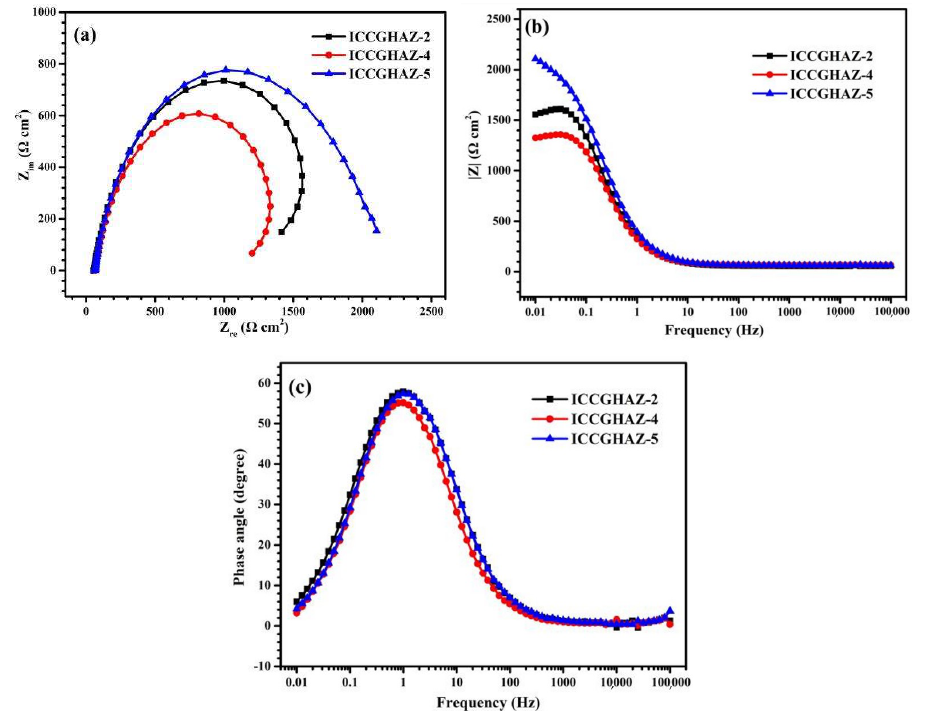
Figure 17. EIS results of the ICCGHAZs with different cooling rates in 3.5 wt% NaCl solution: ( a ) Nyquist impedance diagrams, Bode diagrams of ( b ) impedance magnitude vs. frequency and ( c ) phase angle vs. frequency.